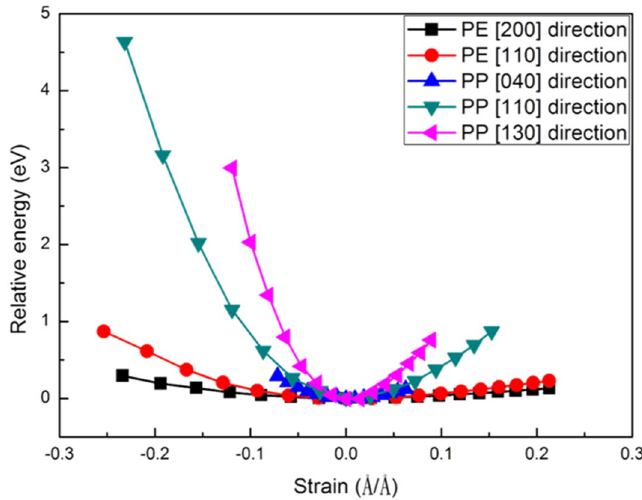
Figure 6. Relative energy-strain curves for PE in [200] and [110] direction and for PP in [040], [110] and [130]